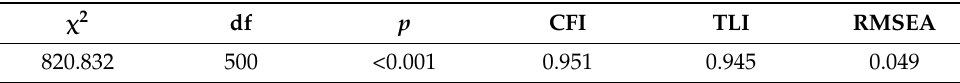
Table 6. Fit of structural equation model.